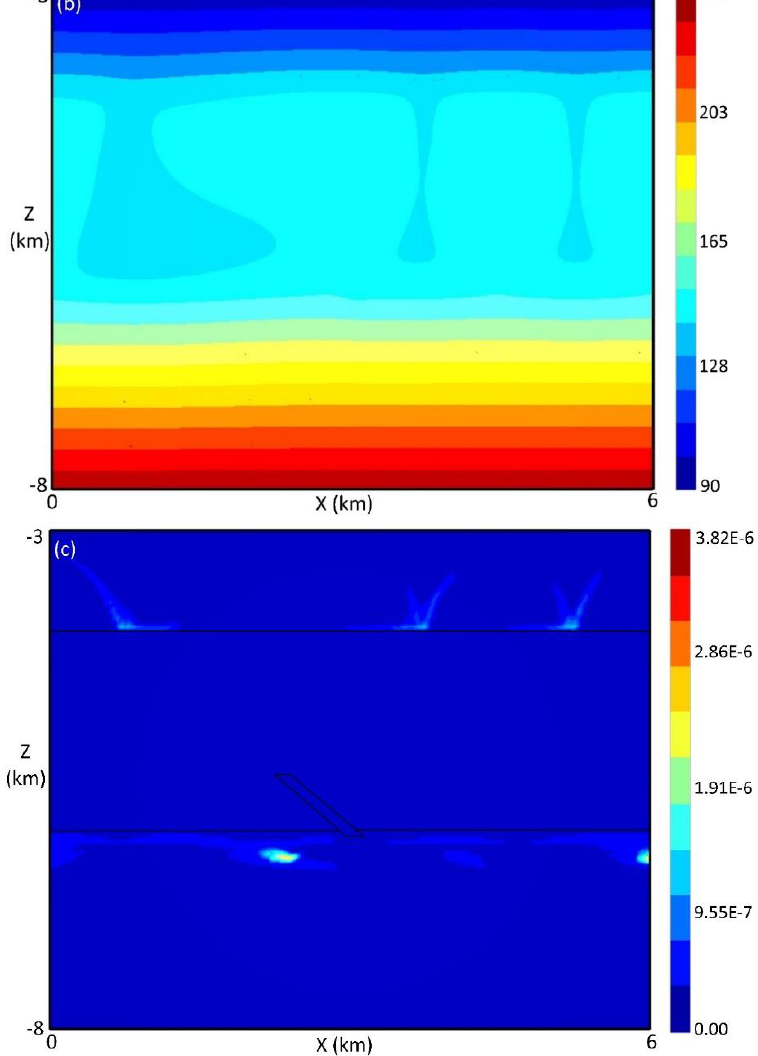
Figure 6. Numerical results at 300,000 years for Scenario 3: ( a ) the flow vectors, ( b ) the temperature distribution, and ( c ) the precipitated uraninite and volume fraction.